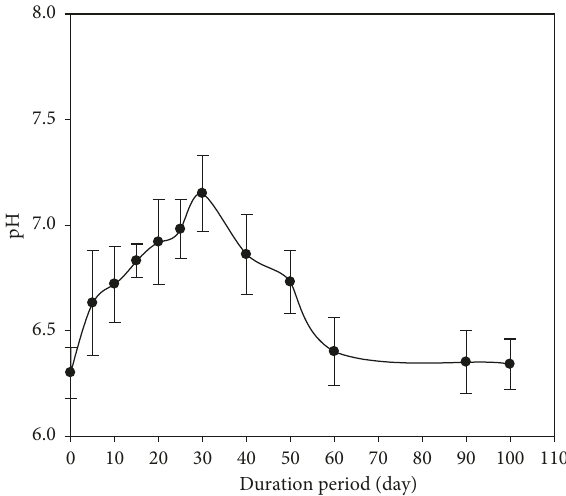
Figure 4: The change in soil pH as a function of the duration period after HCl leaching and fertilized by adding organic